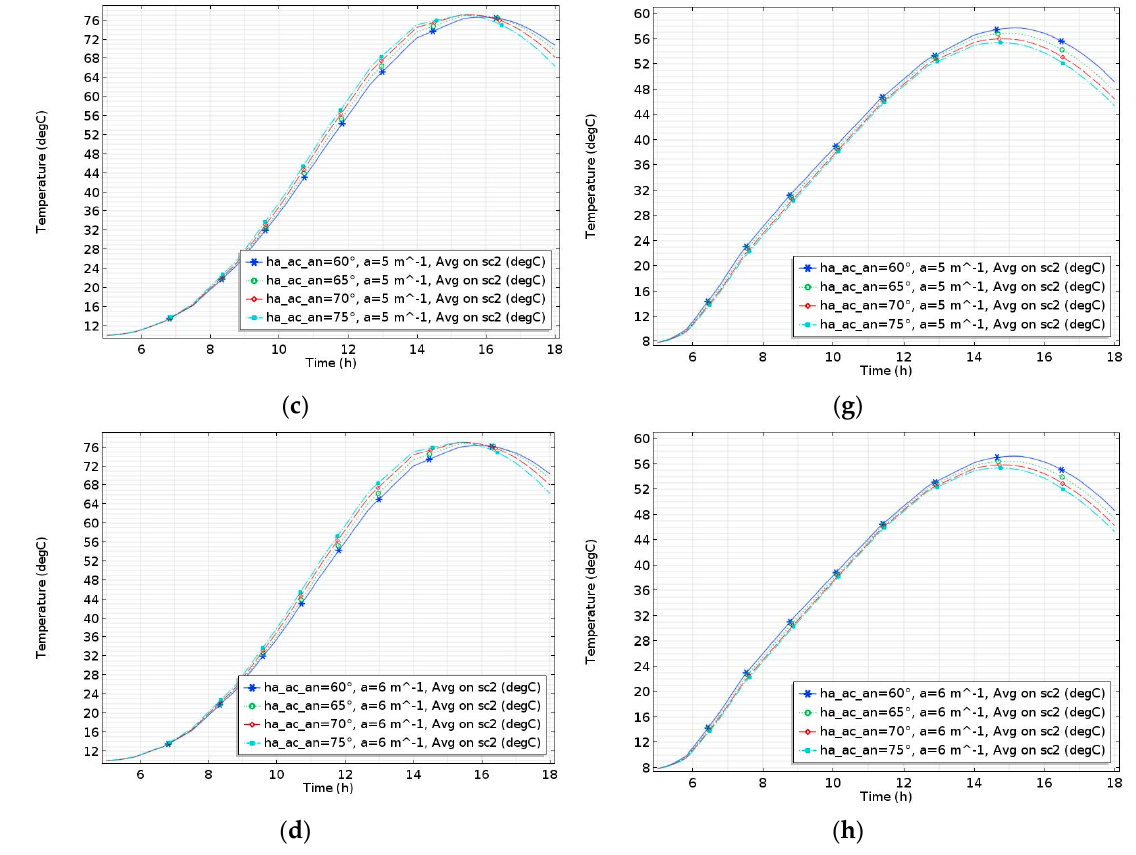
Figure 16. Temperature on solar cell n.2 with different half-acceptance angles and parabola coefficients for the: ( a – d ) covered CPC system; ( e – h ) uncovered CPC system.